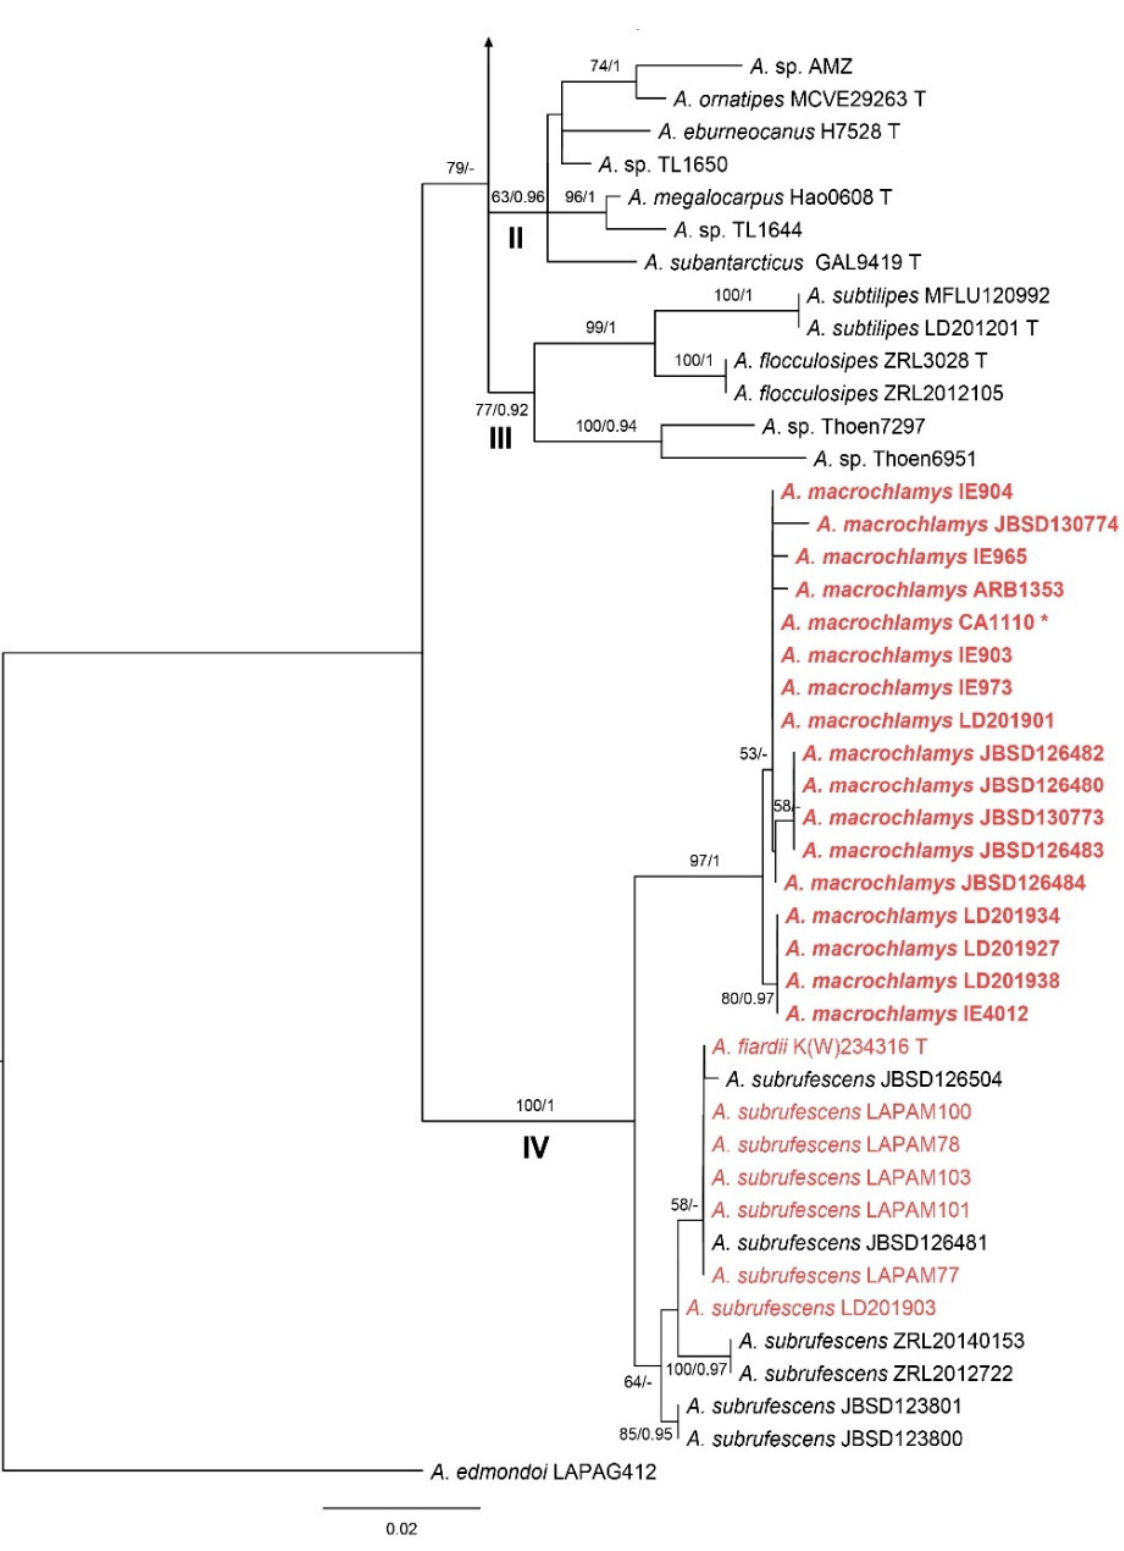
Figure 1. Maximum likelihood (ML) phylogram of Agaricus sect. Arvenses based on ITS and tef1 sequence data. Bootstrap support values and Bayesian posterior probabilities greater than 50/0.9 are indicated on branches. New sequences are annotated in red and new species are in bold. T = Type specimen. * CA1110 is the strain isolation of the holotype.